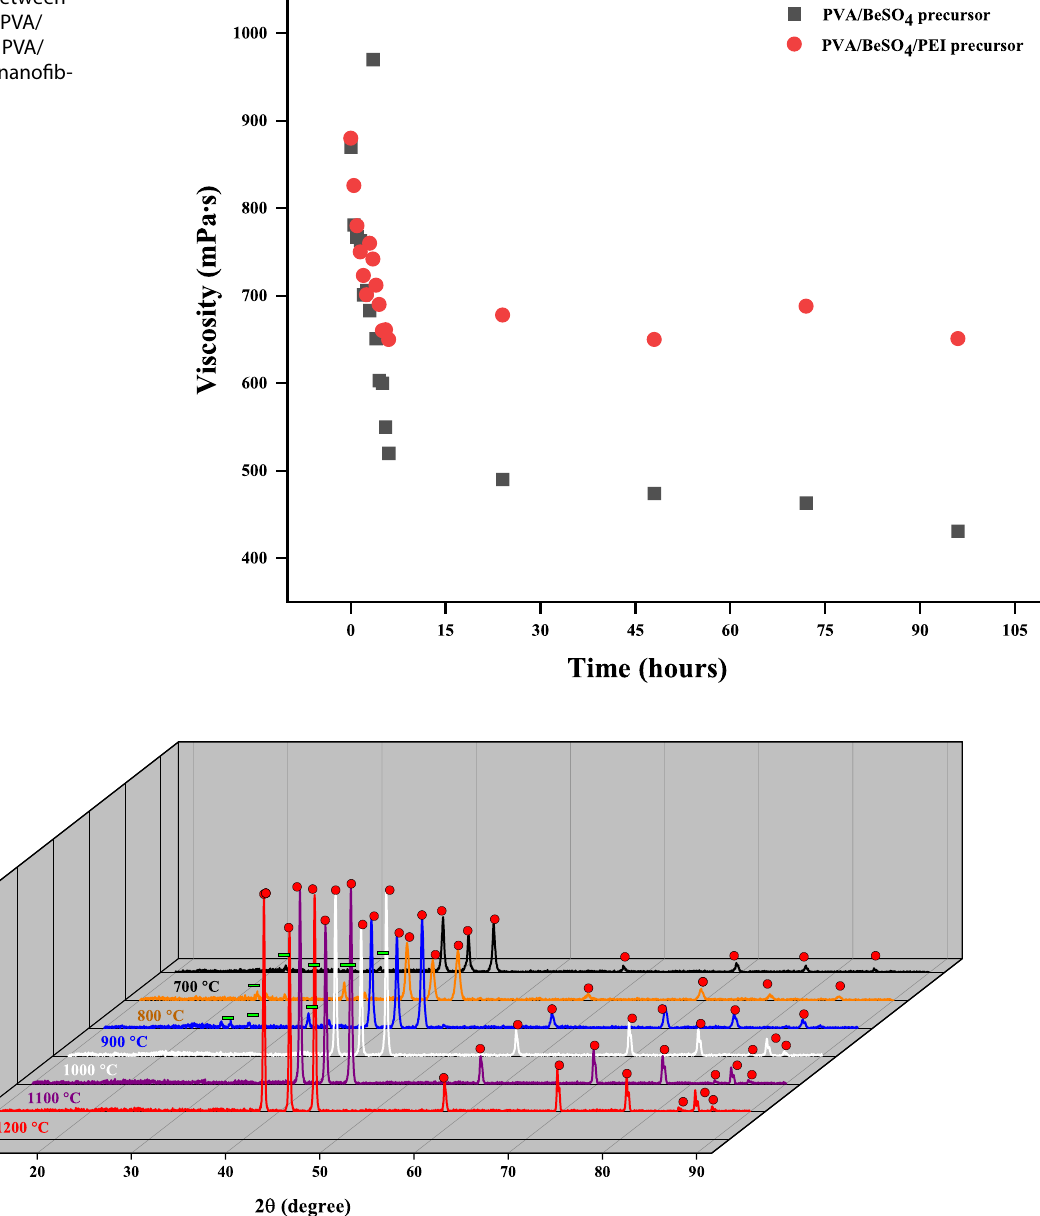
Fig. 4 Relationship between time and viscosity of PVA/ BeSO precursor and PVA/ 4 BeSO